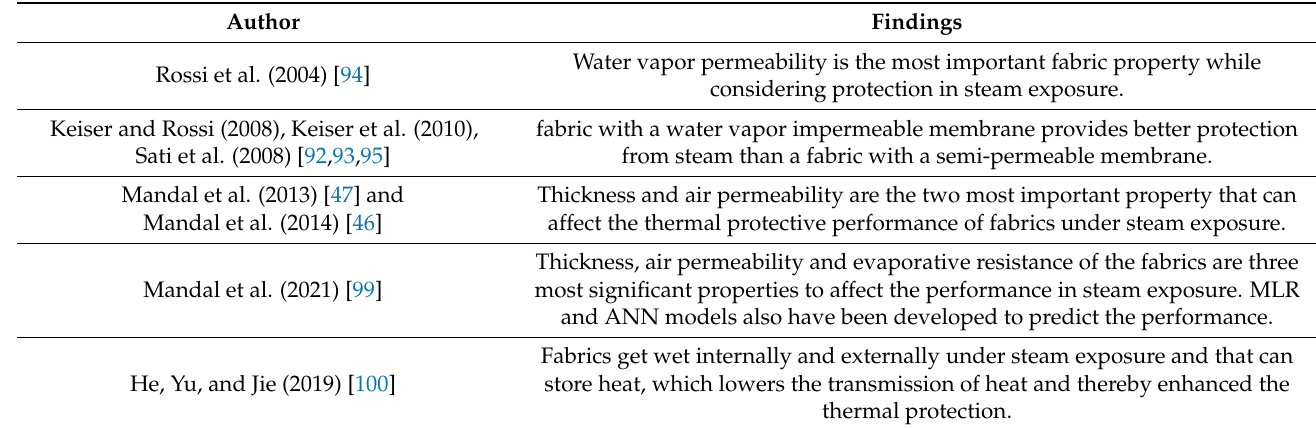
Table 4. Thermal protective performance under steam